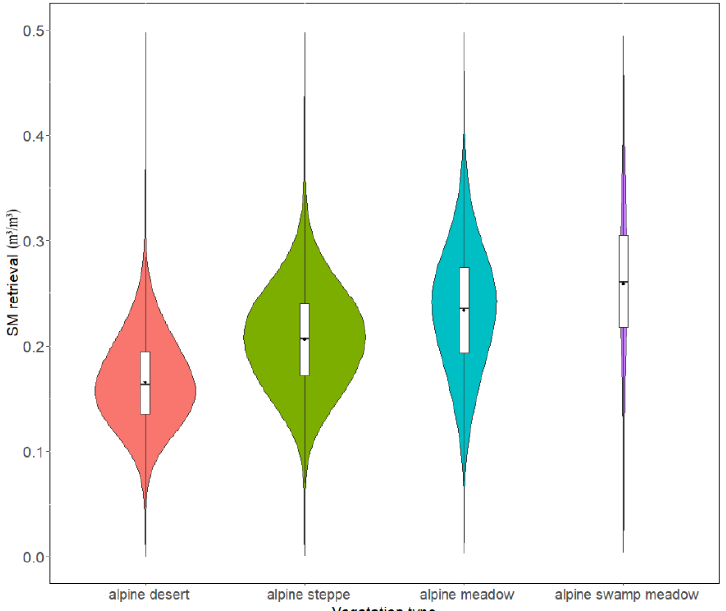
Figure 15. Violin plots of SM content of the four vegetation types. Each violin plot contains a box plot and a kernel density plot. A kernel density plot overlays each box plot. The black marks indicate the median, and the boxes indicate the quarter range of values. The number of samples defines the width of the violin in each subplot.